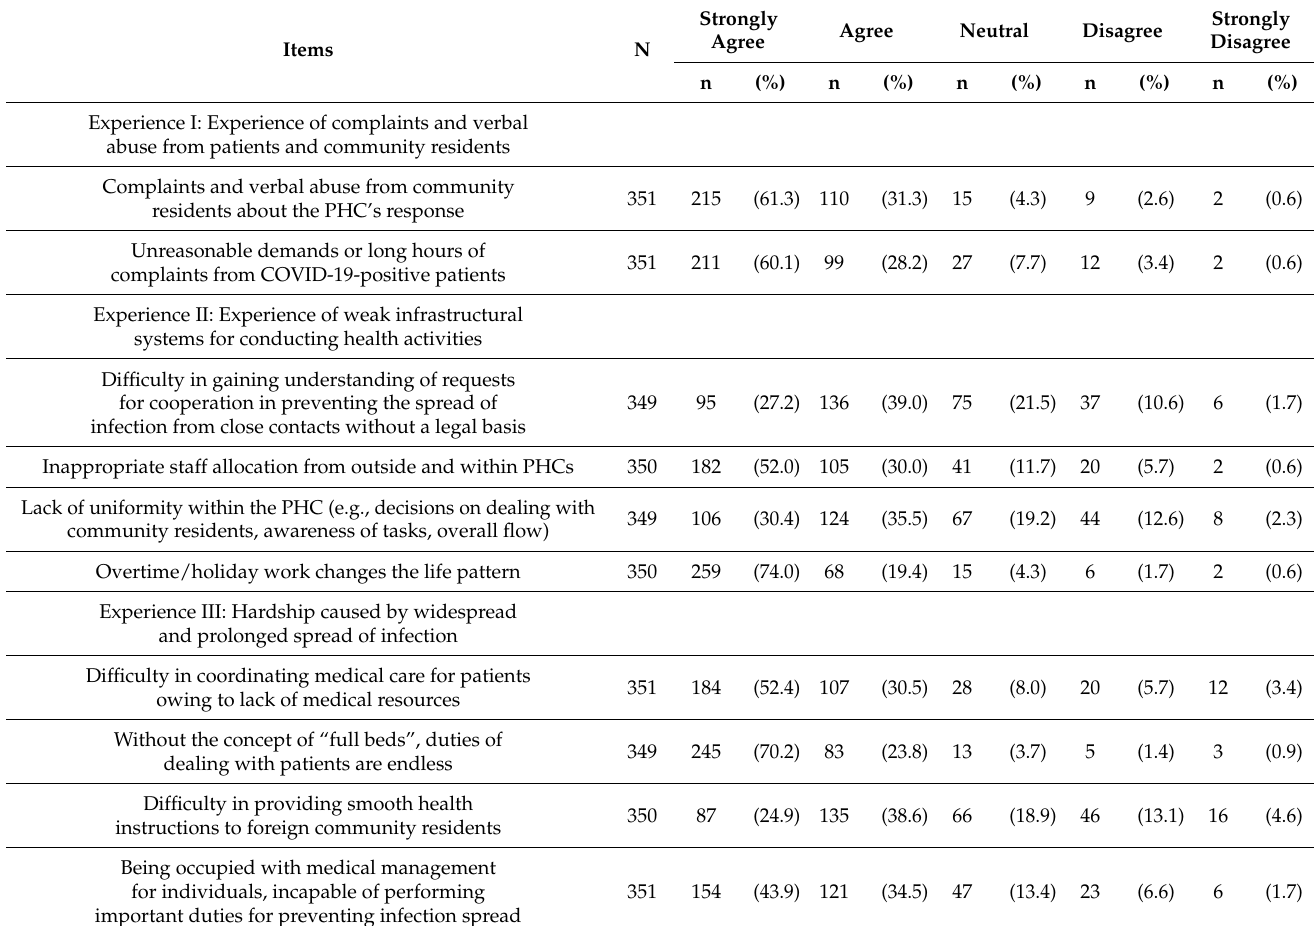
Table 3. Experience rating of each item of the PHN experience during the COVID-19